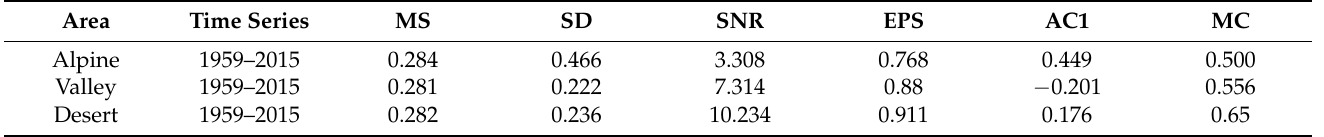
Table 1. Standard chronology characteristics of sampling the